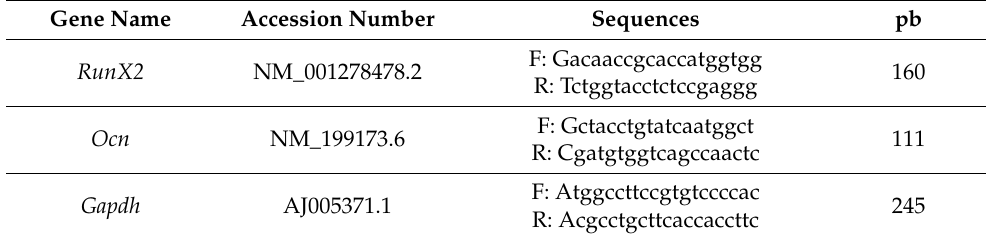
Table 1. Oligonucleotides used for real-time PCR analysis.